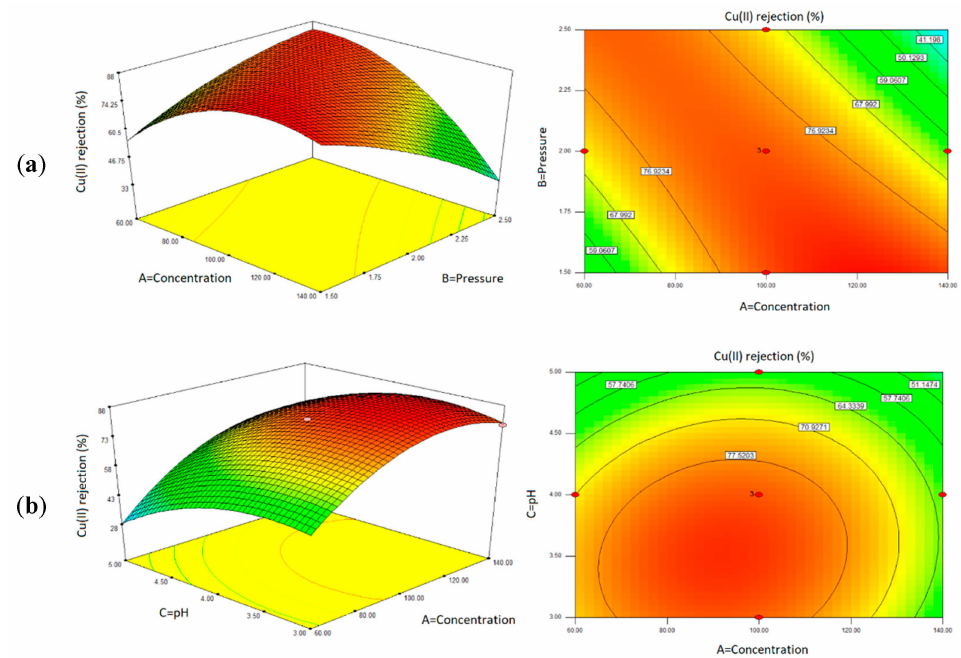
Figure 9. Response surface plots of the interaction effects of filtration factors on the Cu(II) ions rejection: ( a ) concentration and pressure (AB) and ( b ) concentration and pH